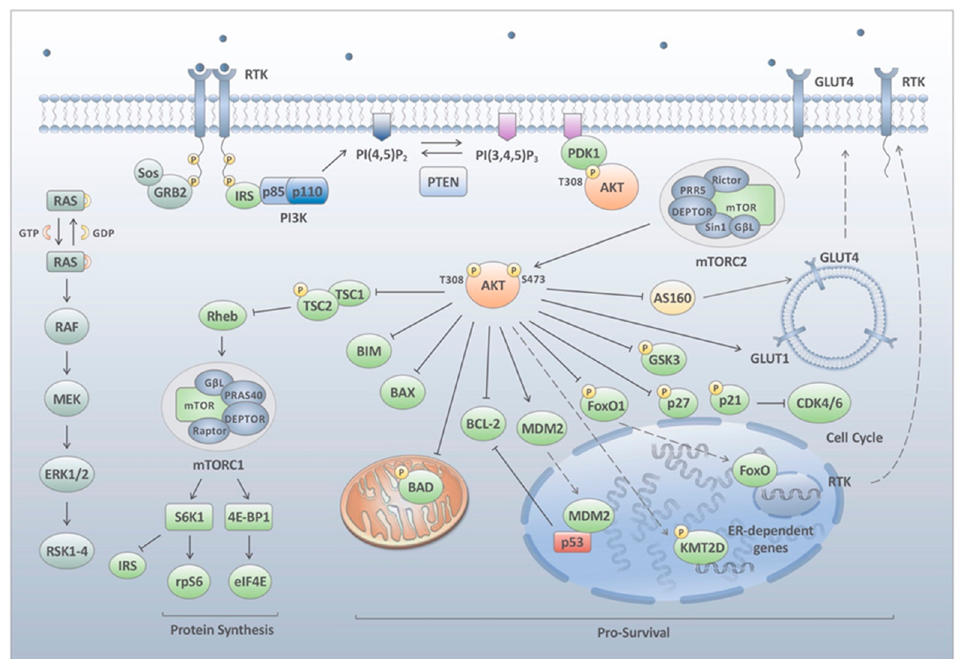
Figure 1. The PI3K and MAPK signalling pathways. Growth factors and other external signalling molecules stimulate the activation of the PI3K and MAPK pathways through receptor tyrosine kinase (RTK) phosphorylation at the cell membrane. Activated RTKs recruit molecules bearing phosphotyrosine-binding (PTB) or Src homology-2 (SH2) domains, such as IRS or p85, respectively. For PI3K enzymes, the binding of the p85 subunit activates the catalytic function of p110, prompting the phosphorylation of phosphatidylinositol 4,5-bisphosphate (PI(4,5)P 2 ) to phosphatidylinositol 3,4,5-trisphosphate (PI(3,4,5)P 3 ). PI(3,4,5)P 3 , a prominent second messenger in cell signalling, accumulates at the cell membrane attracting molecules with pleckstrin-homology (PH) domains, primarily phosphoinositide-dependent protein kinase 1 (PDK1) and the AKT serine/threonine kinase family (protein kinase B/PKB). PDK1 partially activates AKT at threonine 308 through phosphorylation, with full activation enabled by serine 473 phosphorylation via the mammalian target of rapamycin (mTOR) complex 2 (mTORC2). AKT targets various proteins in order to alter major signalling pathways within the cell. These include prosurvival pathways (BIM, BAX, BAD, BCL-2, MDM2 and FoxO1), cell cycle progression and glucose metabolism (p27, GSK3 and AS160), and cellular proliferation and protein synthesis (TSC2). Another prominent effector targeted downstream in the PI3K pathway is mTOR complex 1 (mTORC1), which has been shown to regulate cellular growth and metabolism, amongst other processes. In particular, mTORC1 targets ribosomal protein S6 kinase (S6K) and eukaryotic initiation factor 4E-binding protein 1 (4E-BP1), with the former directly effecting eukaryotic initiation factor 4E (eIF4E) and subsequent translation of cell cycle regulators.